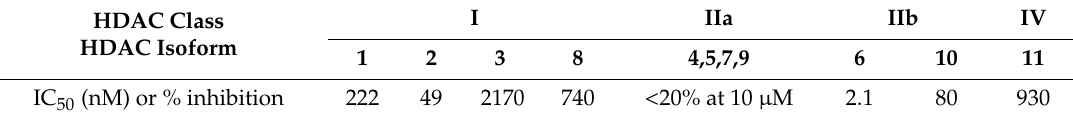
Table 2. Isoform selectivity profile of hybrid 19 against class-I,-II and -IV HDACs. HDAC